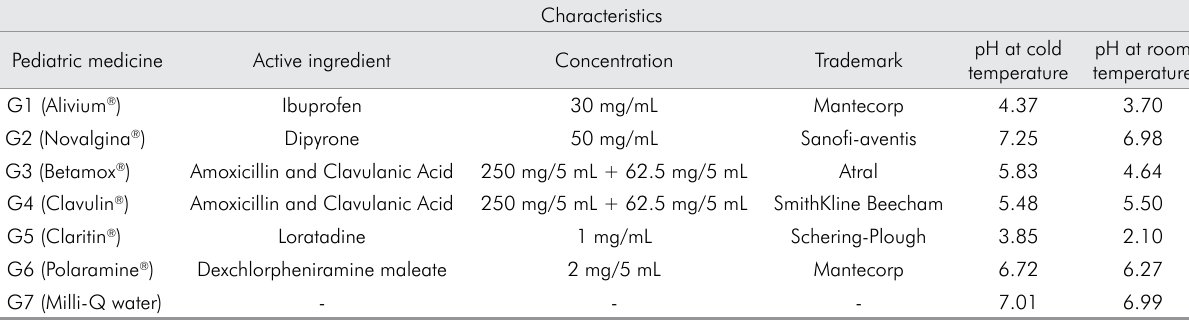
Table 1. Parameters of the pediatric medicines and